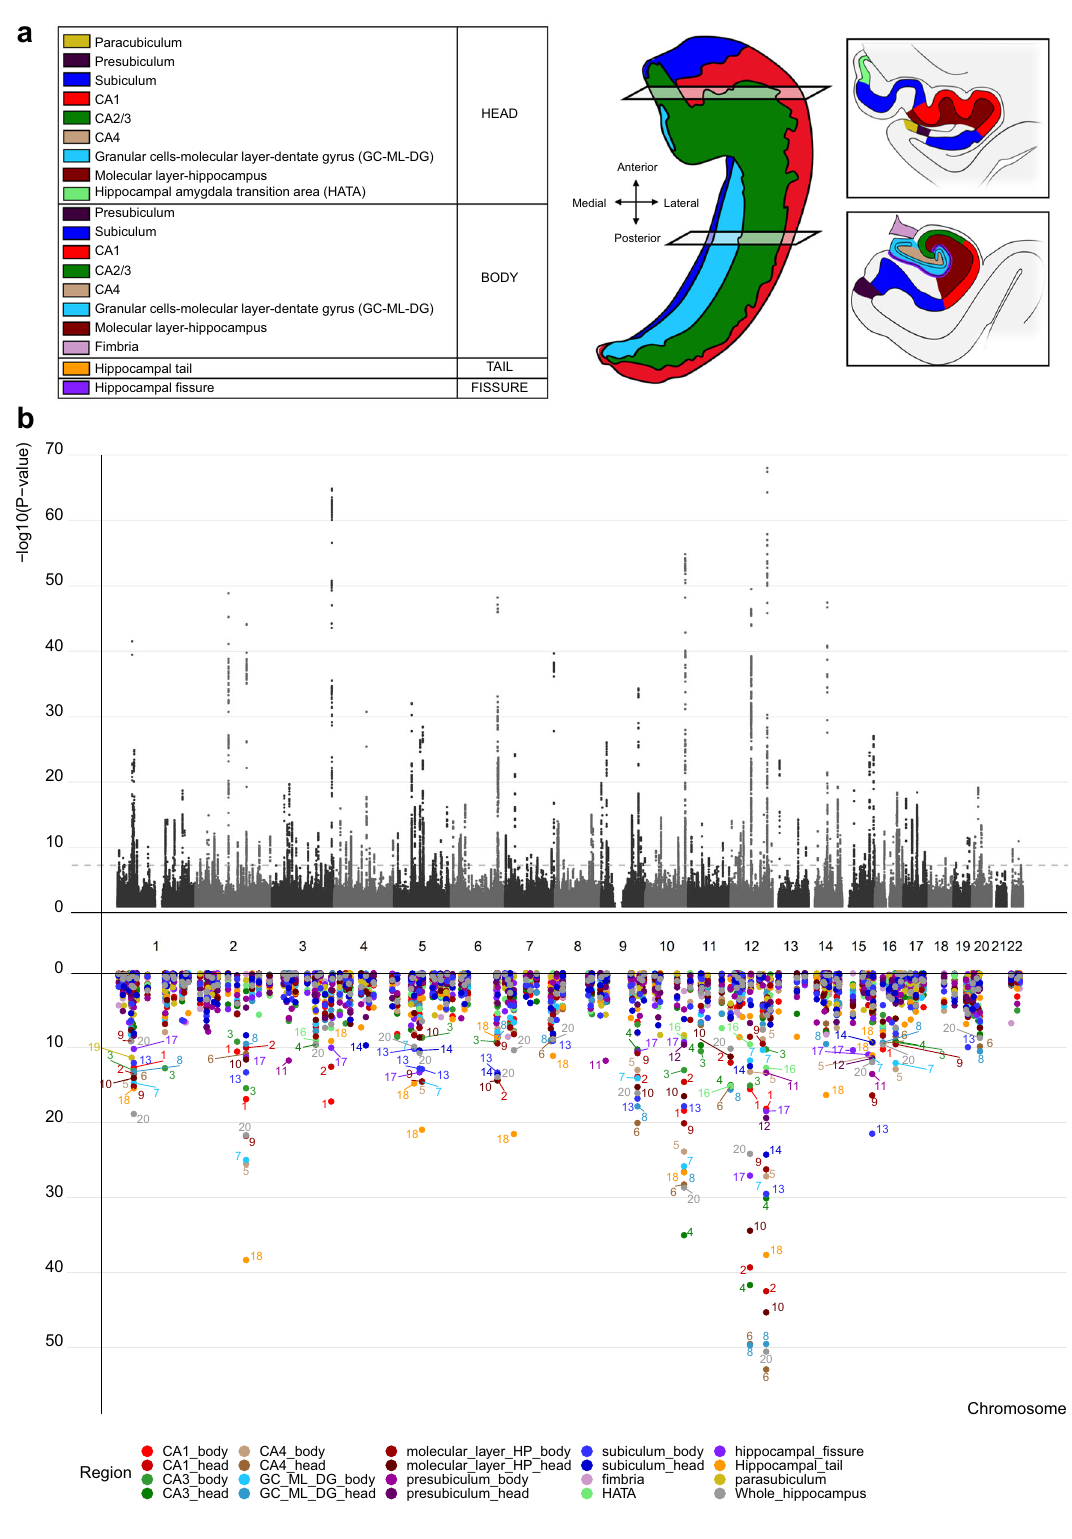
VCAN , mapped from the fi fth strongest locus, all have important roles in neurodevelopment 38 – 40 . Genome-wide gene-based association studies (GWGAS; two- sided P < 2.7 × 10 − 6 ) through MAGMA identi fi ed 303 unique genes across the hippocampus (Supplementary Data 5). Many of the signi fi cant gene sets re fl ected processes related to early development (Supplementary Data 7), such as neurogenesis